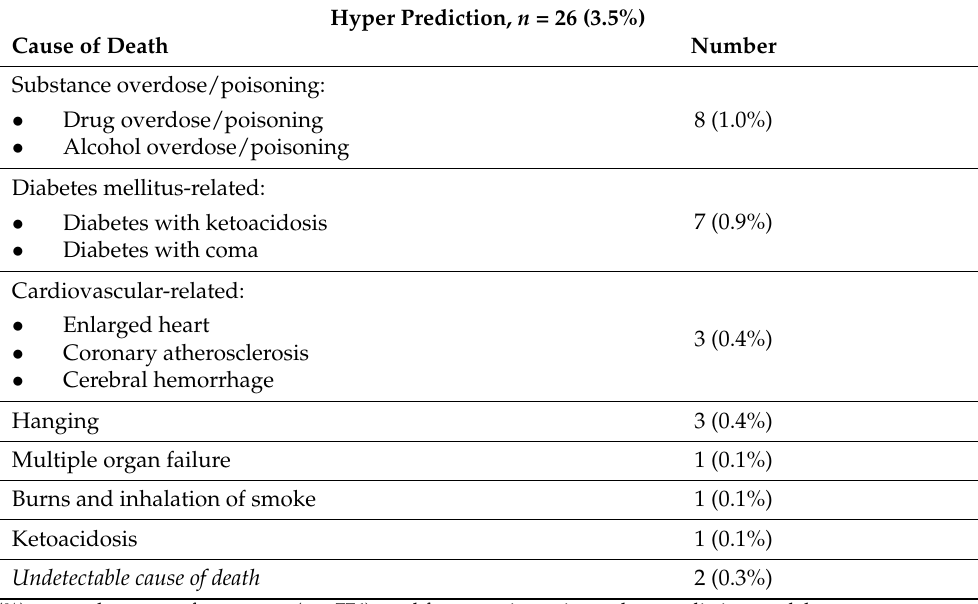
hyperglycemia-related deaths, using a class prediction model based on the insulin intoxication metabolic